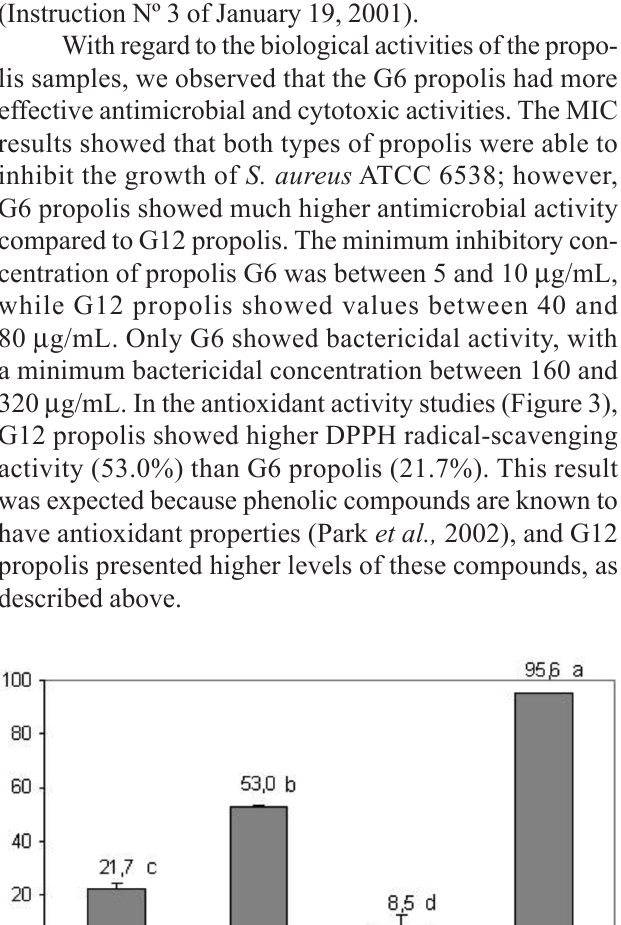
FIGURE 2 - Chromatograms obtained by RF-HPLC of the Ethanolic Extract of Propolis. G12 propolis: 1- Coumaric acid, 2- Ferulic acid, 3- Kanferide, 4- Artepilin C.